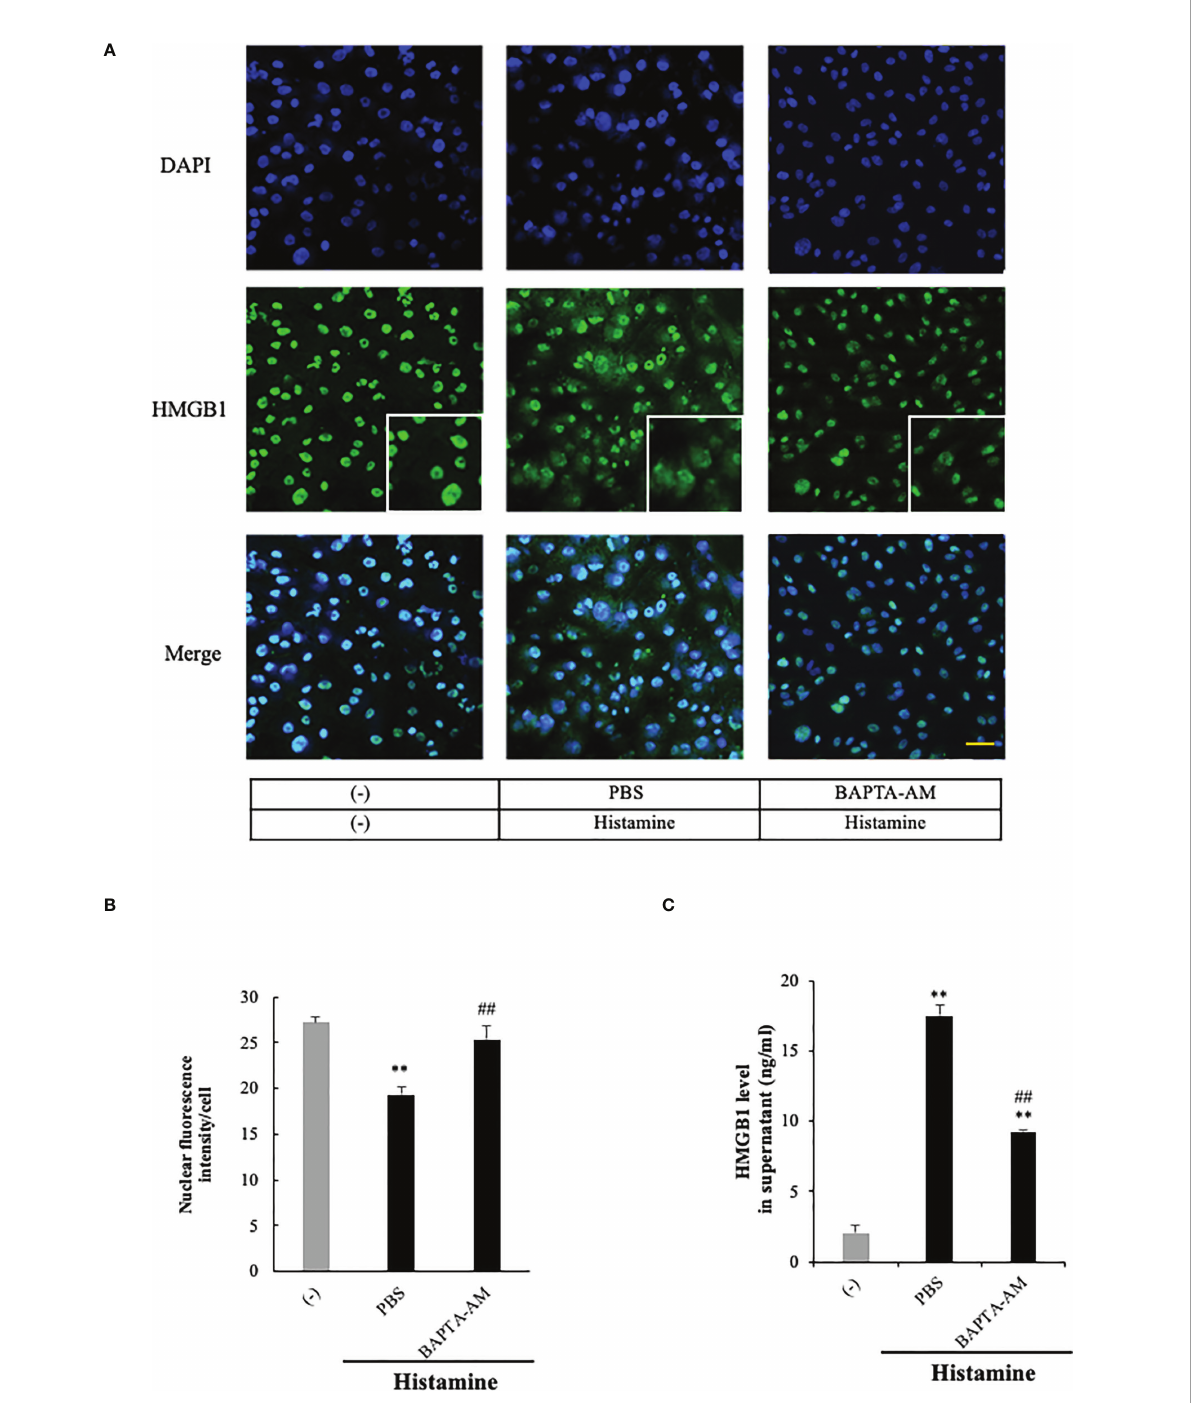
FIGURE 4 Histamine-induced HMGB1 release occurred in a Ca 2+ - dependent manner. (A) Con fl uent EA.hy 926 cells were preincubated with the Ca 2+ chelator BAPTA-AM (5 uM) or PBS for 1 h. The cells were then stimulated with histamine (1 m M) for 12 h. HMGB1 translocation in VECs was observed by immunostaining. Scale bar=10 m m. (B) The results were quanti fi ed by ImageJ software and are expressed as the ratio of total nuclear HMGB1 intensity/cell numbers. (C) The release of HMGB1 into the cell culture medium was measured by ELISA. The results shown are the means±SEM of three experiments, (n=3 per group). One-way ANOVA followed by the post hoc Fisher test. **p<0.01 vs. control in the absence of histamine, ## p<0.01 vs. histamine-PBS